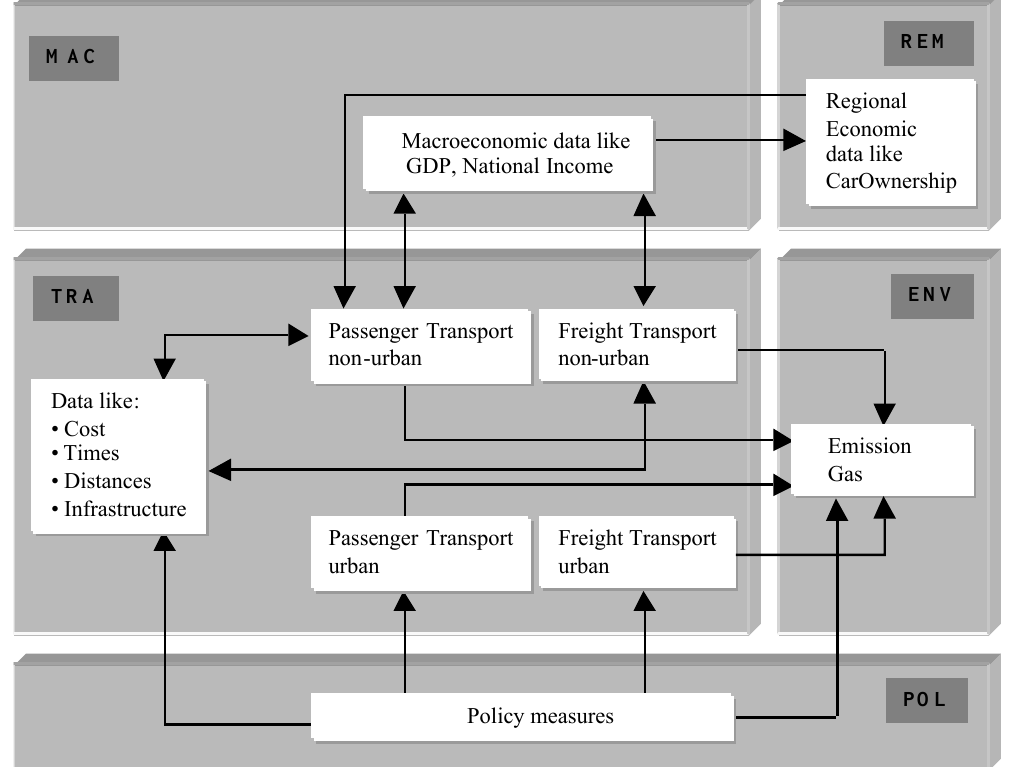
Figure 4. Structure of the Transport Model and its Main Linkages to Other